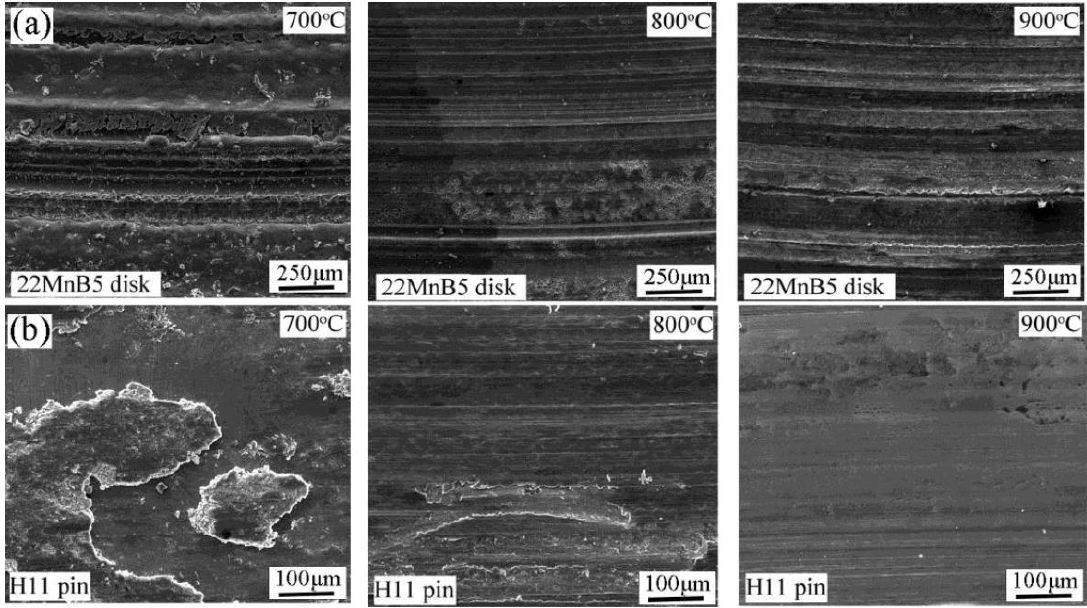
Figure 6. SEM images of the disks ( a ) and the pins ( b ) after 200 cycles when tested at different Figure 6. SEMimages of thedisks ( a ) andthe pins( b ) after200 cycleswhen testedat different temperatures.